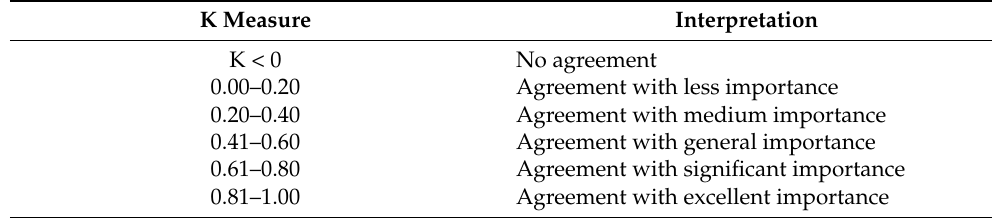
Table 5. Interpretation of K measure [18].